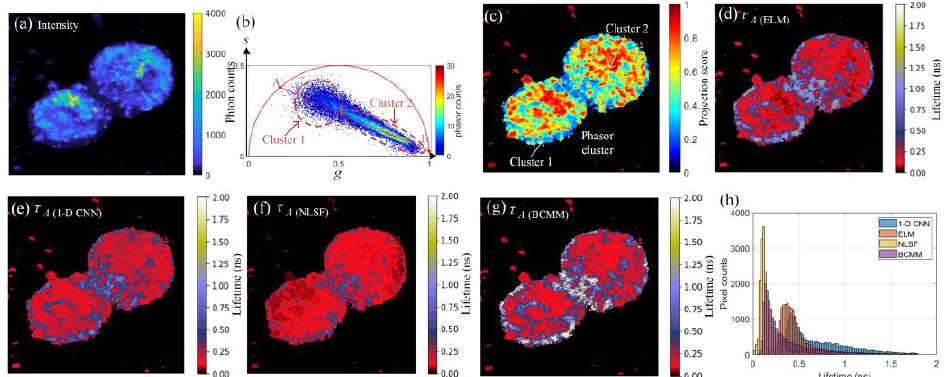
Figure 8. Lifetime analysis of prostatic cells loaded with gold nanoprobes. ( a ) The intensity image, ( b ) phasor plot, and ( c ) phasor projection image. ( d – g ) τ A restored by ELM, 1-D CNN, NLSF, and BCMM. ( h ) Lifetime histograms of ELM, 1-D CNN, NLSF, and BCMM.